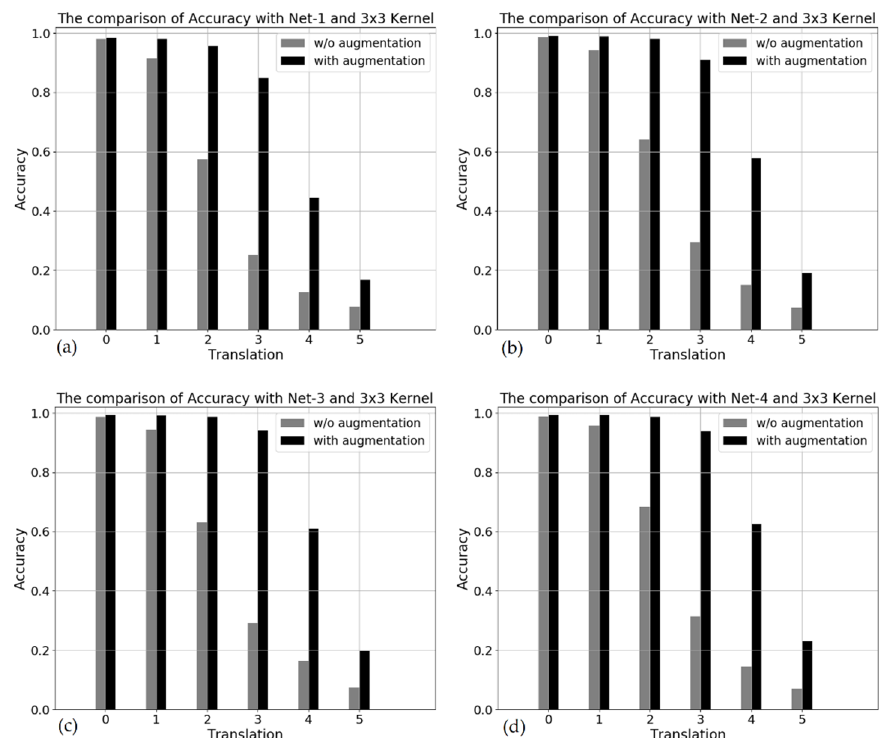
Figure 8. The comparison of networks with and without augmentation within 2-pixel translation by varying network depth with the same 3 × 3 kernel size. ( a – d ) for the Net-1, Net-2, Net-3 and Net-4 networks, respectively.